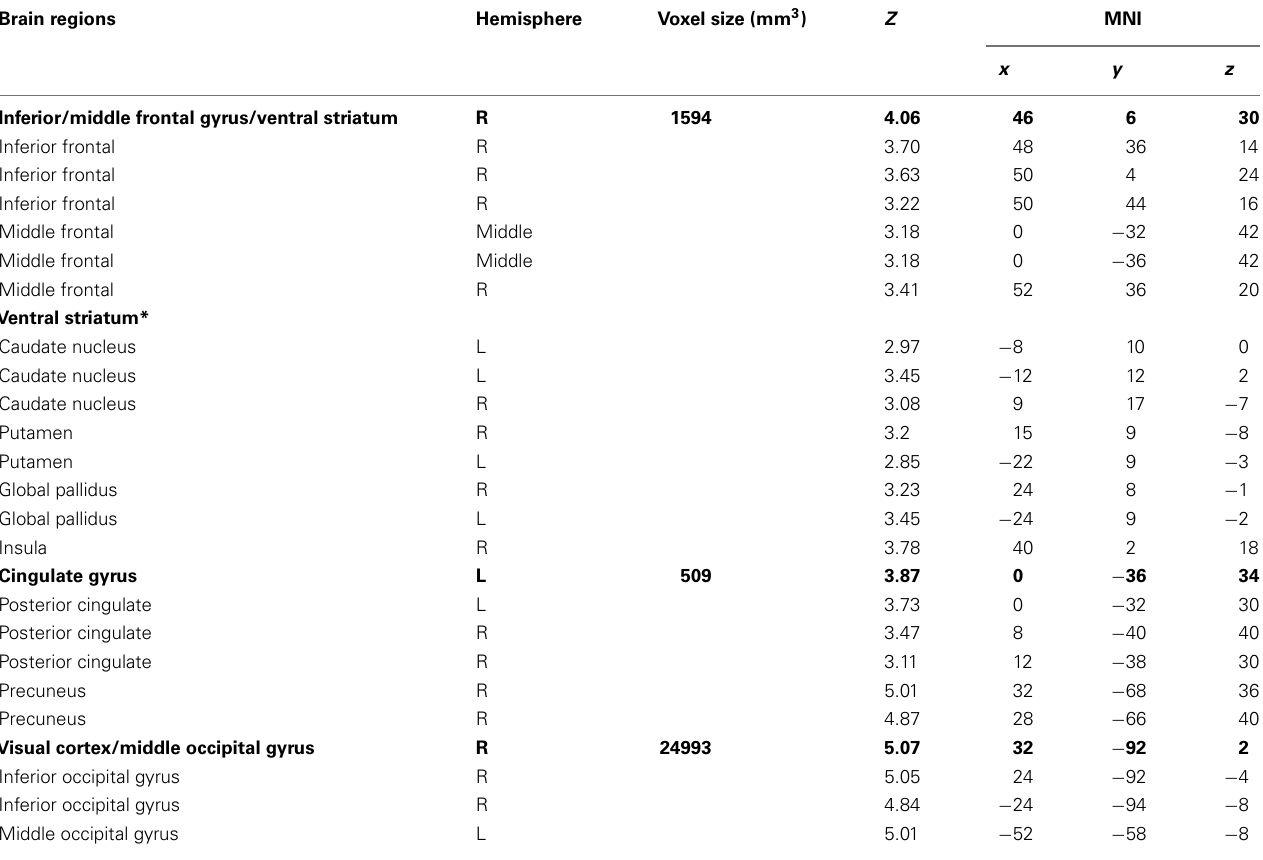
Table 2 | Peak activations for the outcome phase: peak activations for reward > no reward.